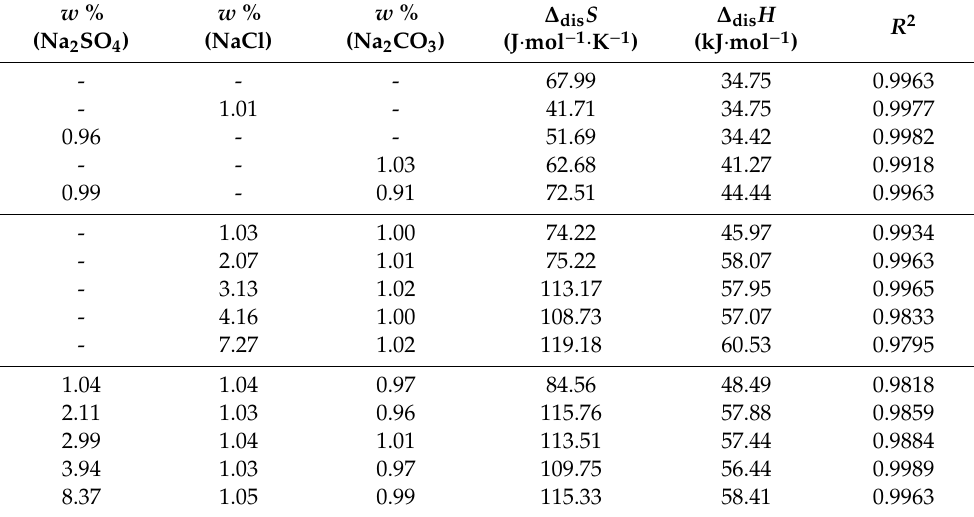
Table 1. Dissolution enthalpy ( ∆ dis H ) and entropy ( ∆ dis S ) of